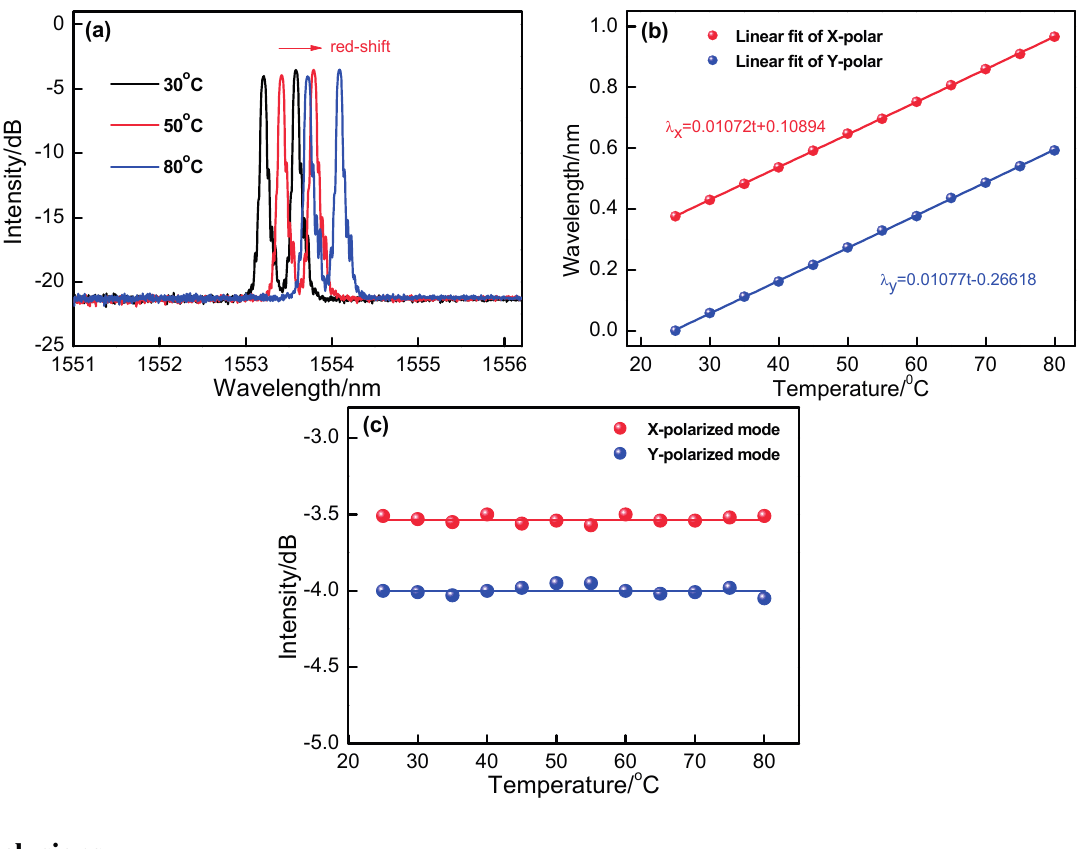
Figure 6. ( a ) Experimentally measured reflection spectra of the x - and y -polarized modes which shows red-shift over the heating process; ( b ) The reflection wavelengths versus temperature; ( c ) Their corresponding intensities